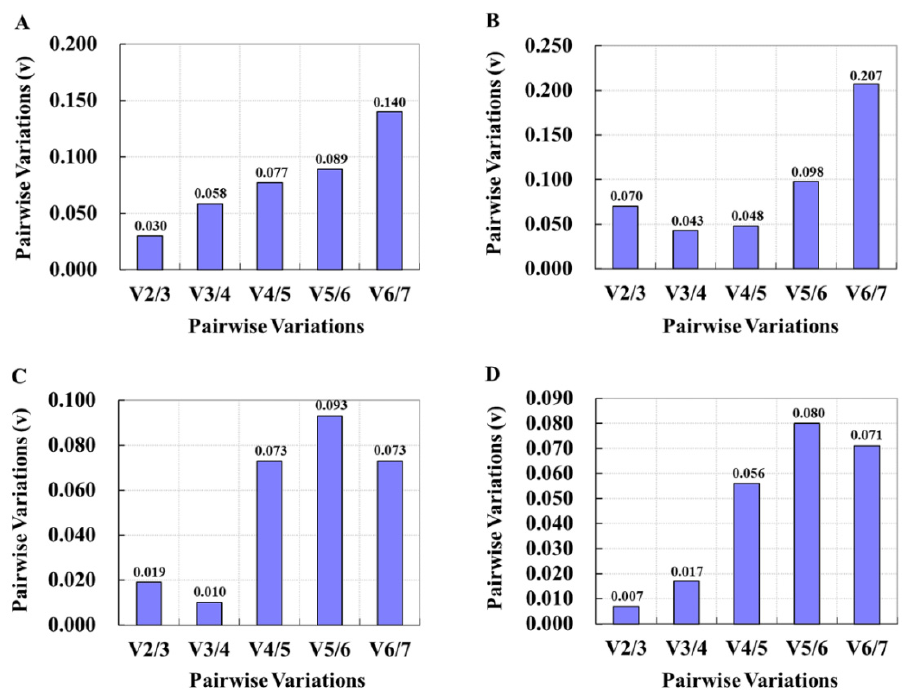
Figure 6. Optimum pairs of housekeeping gene candidates necessitated for normalization in GPHK cells under stimulation with LPS for 2 ( A ), 4 ( B ), 8 ( C ) and 12 h ( D ) according to geNorm analysis. The optimal number of reference genes depends on the V n/n+1 value via geNorm analysis; moreover, the value is popularly less than 0.15.